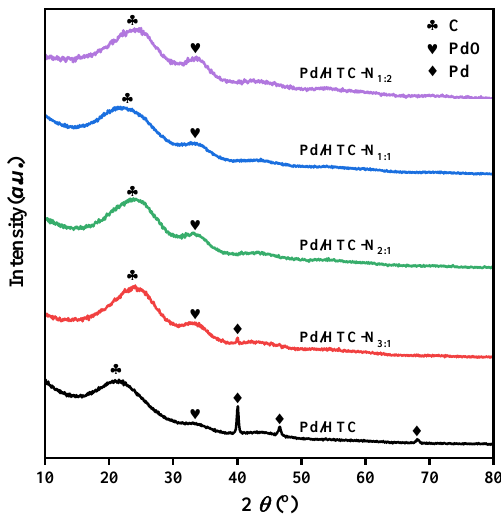
Figure 6. XRD patterns of the different catalysts.